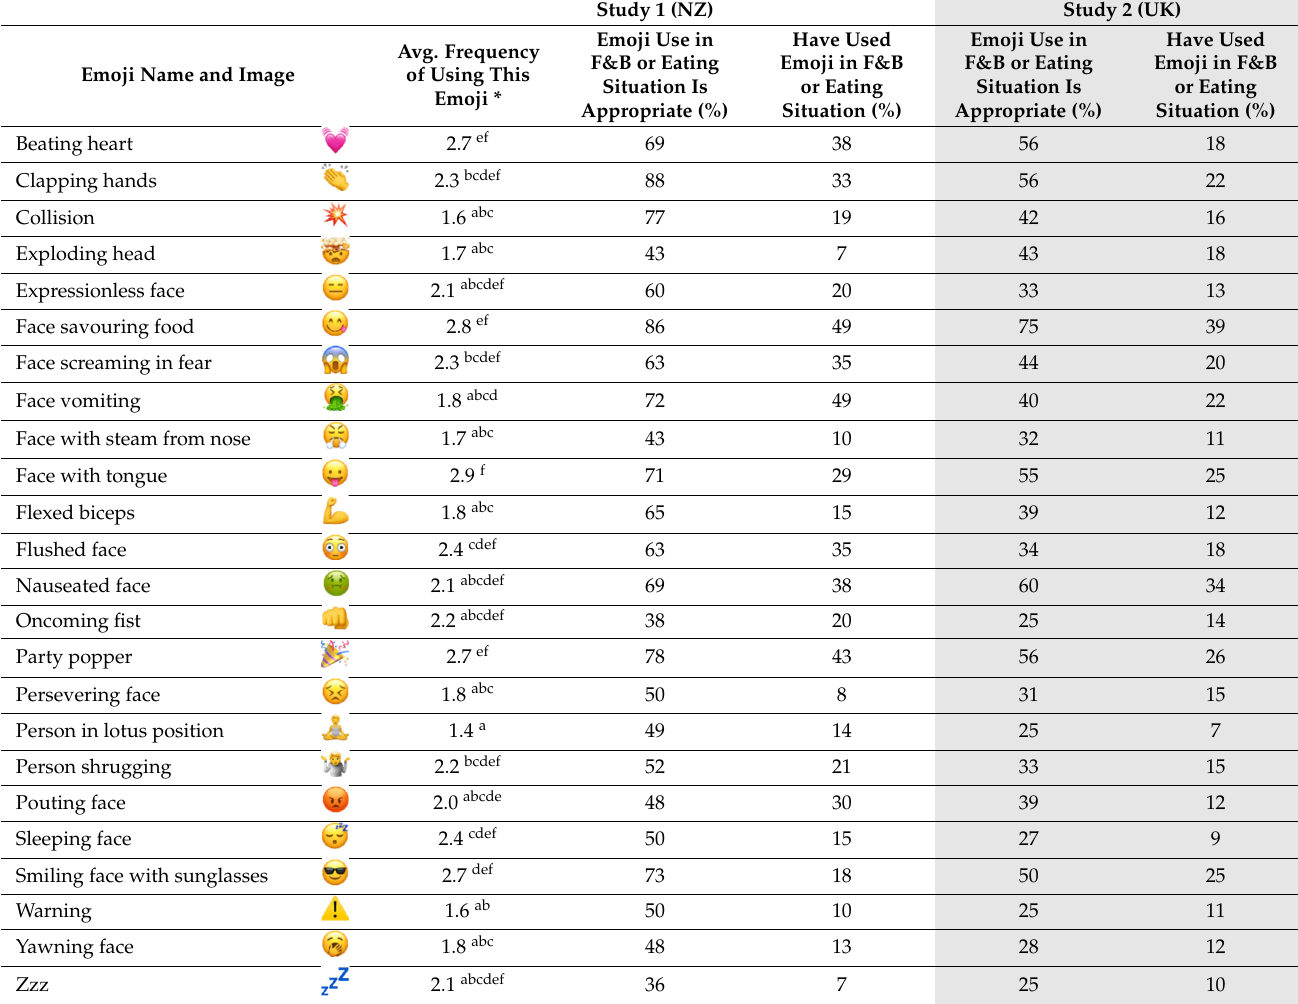
Table 2. Emoji use characteristics among participants in the two studies. In Study 1 (NZ) each emoji was evaluated by 40 to 43 participants and in Study 2 (UK) each emoji was evaluated by 99 to 116